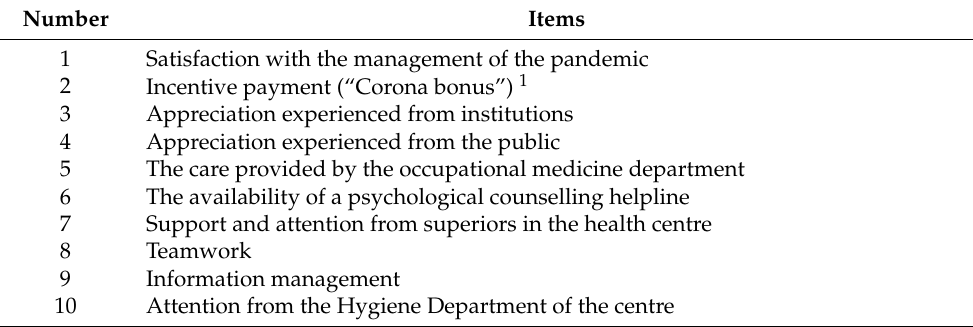
Table 2. Mental satisfaction scale during the COVID-19 pandemic (MS A DCP, Satisfaction Scale).